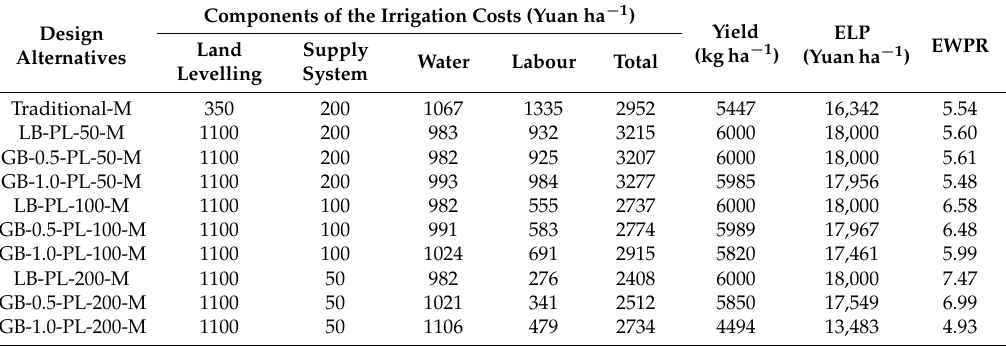
Table 11. Irrigation costs of various design alternatives and their cost components compared with yields, economic land productivity (ELP), and economic water productivity ratio (EWPR) of several projects for a medium infiltration soil and assuming medium inflow